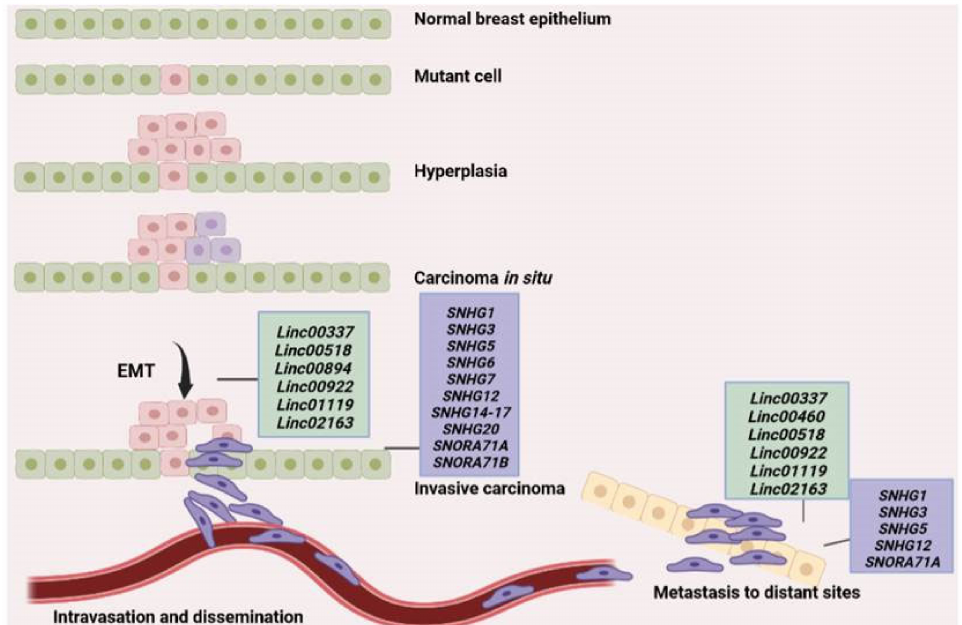
Figure 1. Schematic representation of the metastatic process. A mutation in one of the cells of the normal breast epithelium leads to hyperplasia, while accumulation of additional mutations leads to tranformation of cells into cancer cells and the generation of a tumor that is initially confined to the primary site (carcinoma in situ). Upon activation of various molecular pathways, cancer cells undergo EMT and some of them eventually migrate and invade surrounding tissues or intravasate into neighboring blood vessels through which they are able to reach distant organs or parts of the body where they can extravasate, adhere and establish a new metastatic tumor in the new site. The long intergenic noncoding RNAs (lincRNAs) and small nucleolar RNA (snoRNA) found to be involved in the major steps of the metastatic process are shown in green and purple boxes,